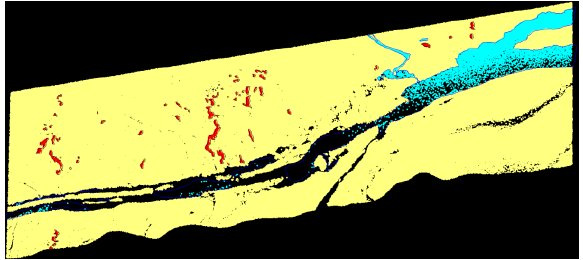
Fig. 4: Labelled point cloud for the dataset in the Wadden Sea with the three classes water (blue), mussel bed (red), and mudflat